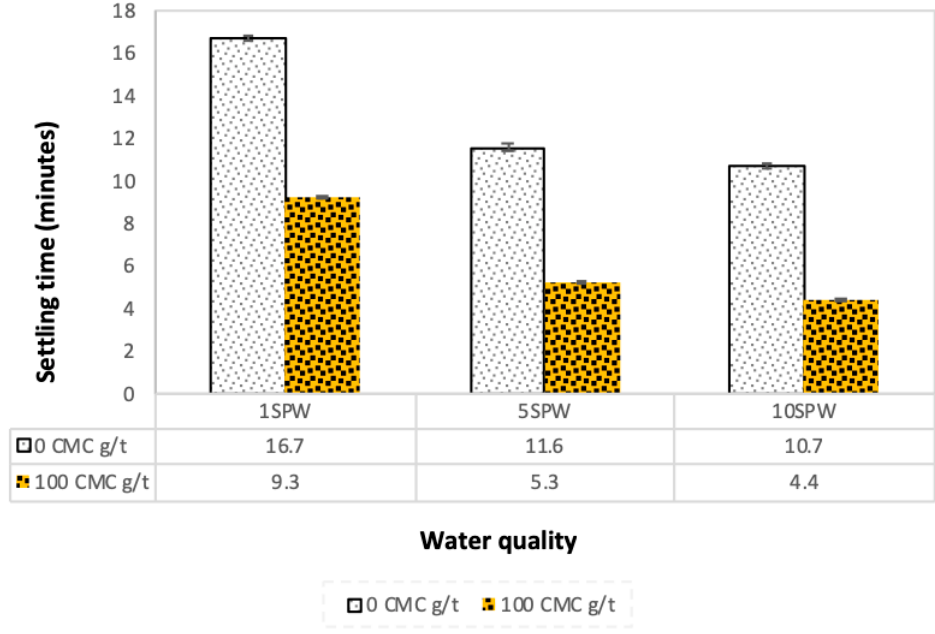
Figure 13. Solids settling time as a function of the ionic strength of SPW and CMC dosages.